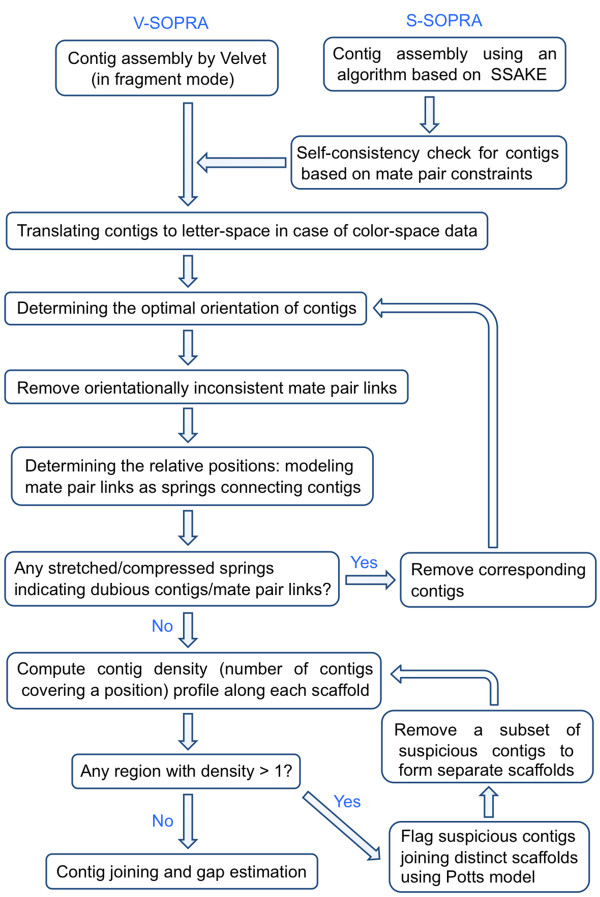
Flow chart of the algorithm. In principle, the contig assembly can be performed using any of the available contig assembly algorithms. SOPRA uses the mate pair information to assemble contigs into scaffolds. S-SOPRA and V-SOPRA correspond to the integration of SOPRA with SSAKE and Velvet respectively.